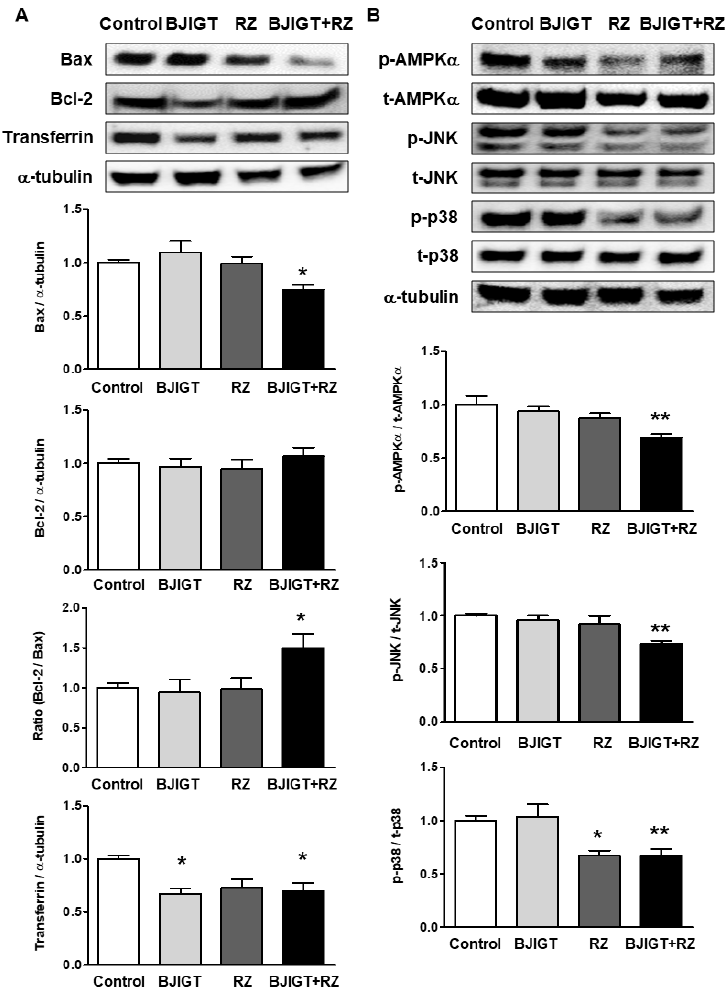
Figure 5. Cellular stress-related factors were decreased by BJIGT and RZ administration in the liver of hSOD1 G93A mice. ( A ) Representative bands of Bax, Bcl-2, transferrin, and α -tubulin expression are shown. Densitometric analysis indicated the quantification of Bax, Bcl-2, and transferrin expressed as relative expression levels after normalization to α -tubulin. ( B ) Representative bands of p-AMPK α , t-AMPK α , p-JNK, t-JNK, p-p38, t-p38, and α -tubulin expression are shown. Densitometric analysis indicated the quantification of p-AMPK α , p-JNK, and p-p38, expressed as the ratio of p-AMPK/t-AMPK α , p-JNK/t-JNK, or p-p38/t-p38. Data are presented as the mean ± SEM; * p < 0.05, ** p < 0.01, vs. control. n = 5–9 mice per experimental group.